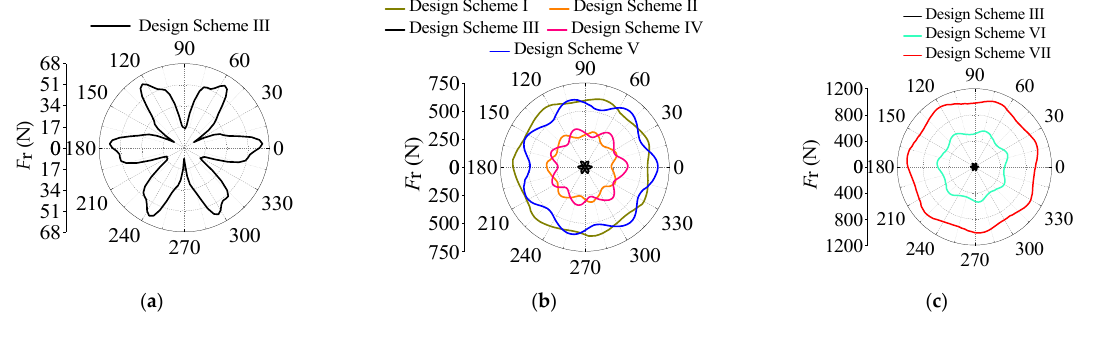
Figure 17. Trajectory distributions of the radial force under 1.0 Q des conditions: ( a ) no deviation; ( b ) deviation of a single blade and ( c ) deviations of two blades.